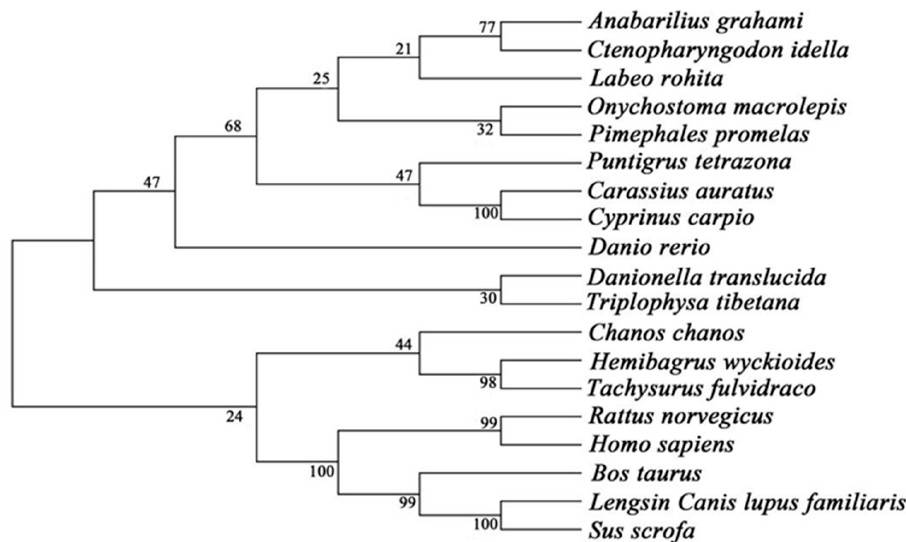
Figure 1. Phylogenetic analysis of GS gene. The tree is built on an alignment corresponding to full-length amino acid sequences using MEGA (4.0) and the Clustal W method. Branch numbers denote the bootstrap majority consensus values for 1000 replicates. The accession numbers are as follows: Triploid Carassius carassius, QXO15199.1; Cyprinus carpio, KTG44256.1; Anabarilius graham,